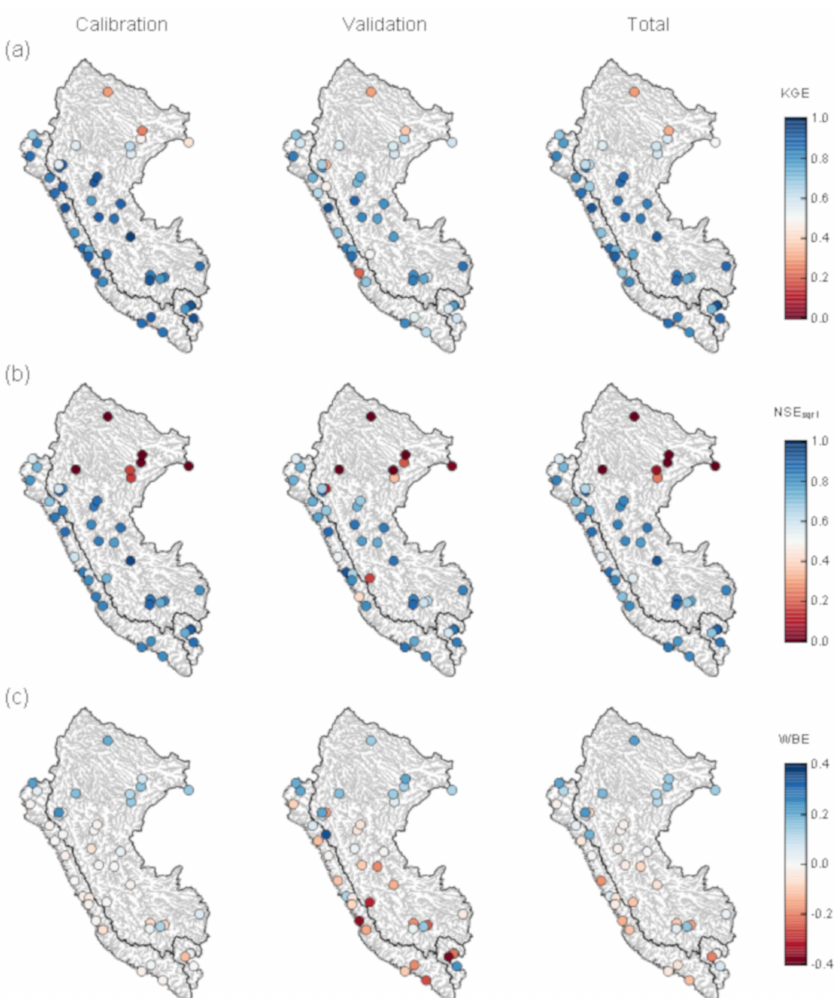
Figure 6. ( a – c ) Statistical metrics for evaluating the GR2M model performance at a national level during the calibration, the validation, and the total period. In terms of the KGE and NSE sqrt metrics, cold colors represent good model performance while warm colors represent inadequate model performance. In WBE, blue colors are associated with the underestimation of the total volume of surface runoff and red colors indicate the